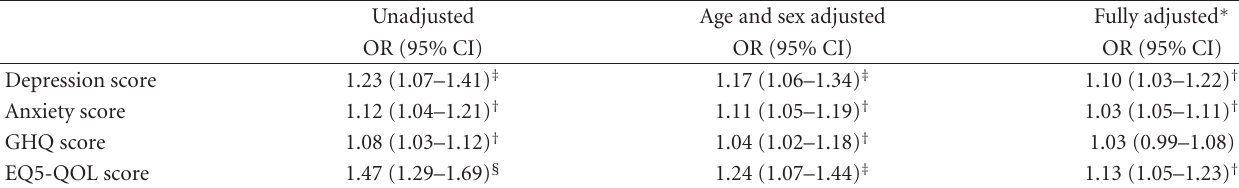
Table 3: Unadjusted and fully adjusted ORs of psychological Factors with metabolic